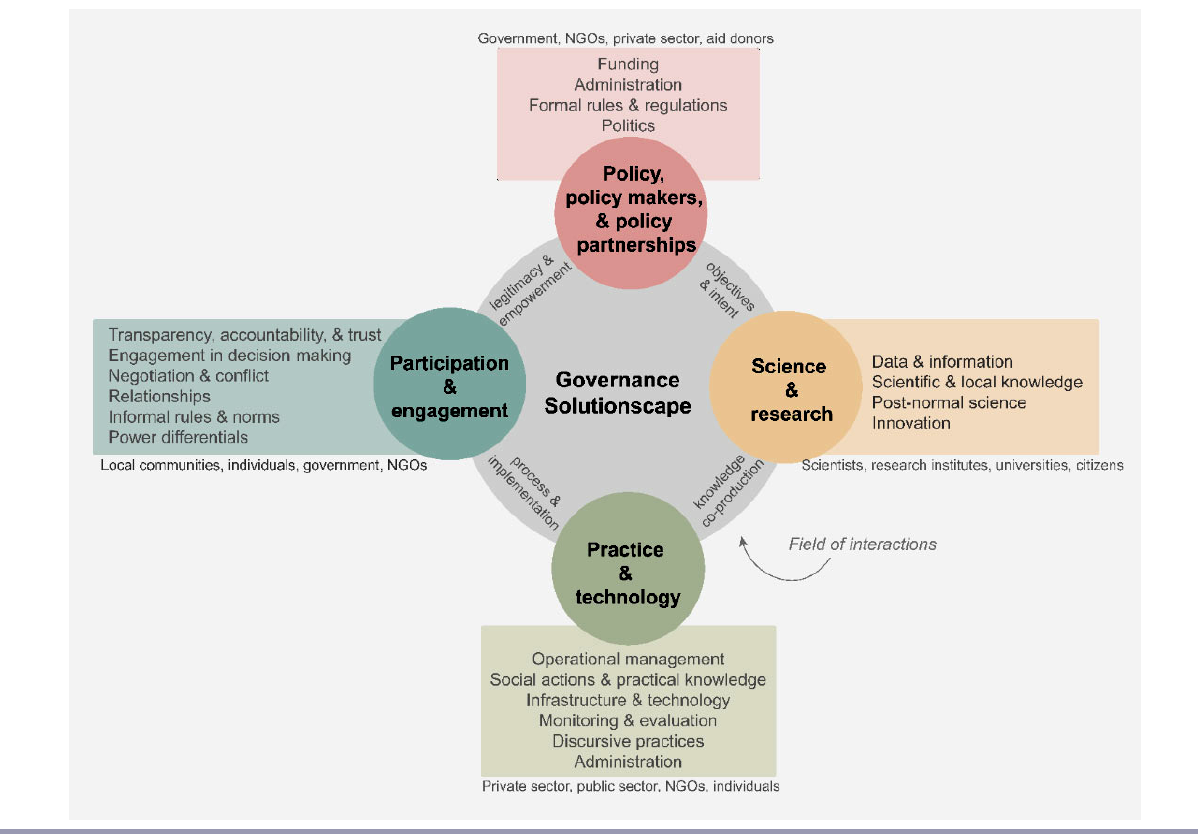
Fig. 1 . The water governance solutionscape of